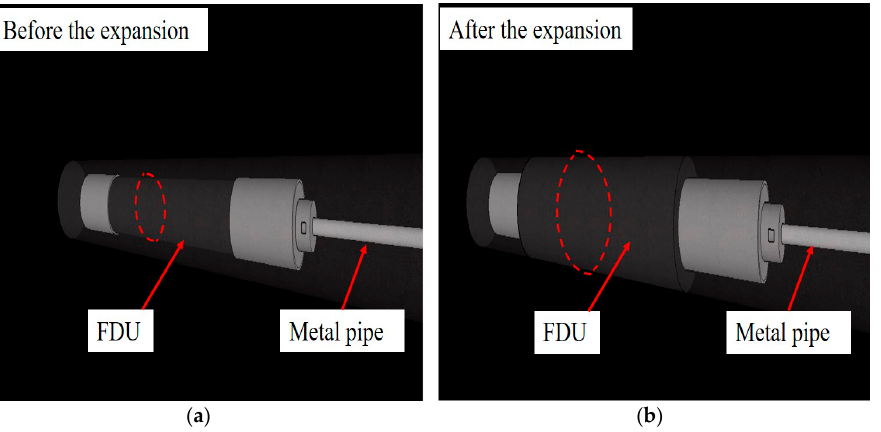
Figure 2. Comparison picture of the FDU before and after applying pressure: ( a ) Before the expansion. ( b ) After the expansion.